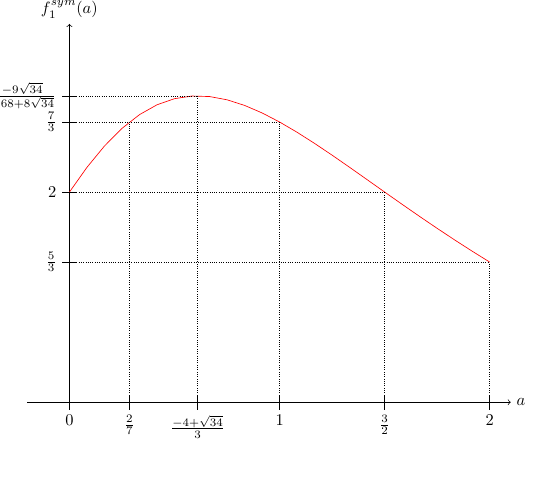
Fig. 4. The first parametric function, f sym